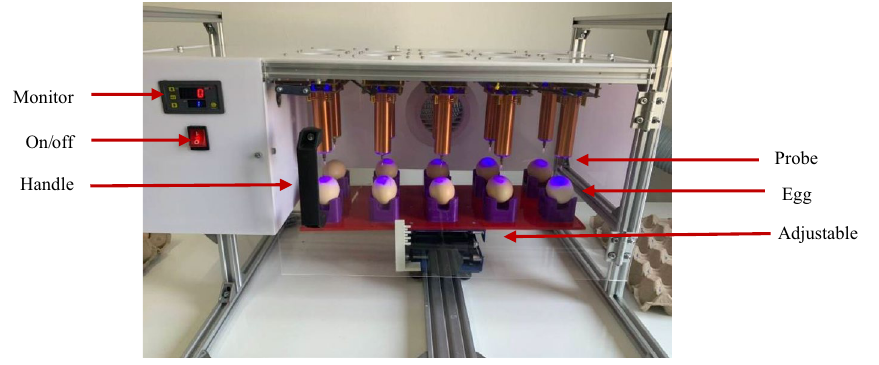
Figure 4. Set-up of 5 × 2 array transient spark plasma device and egg samples